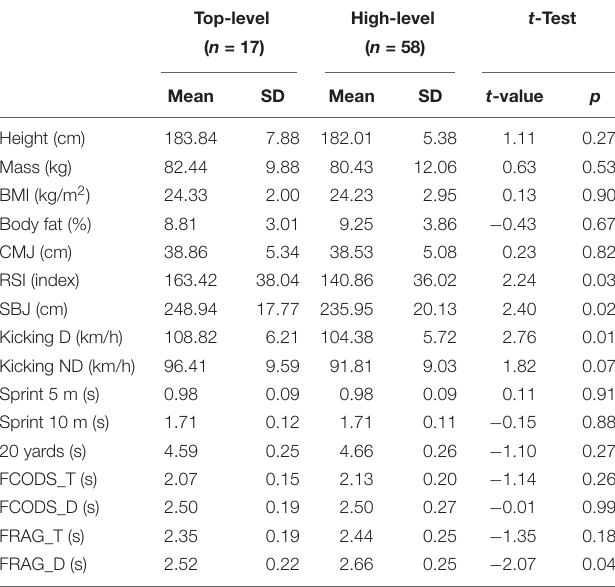
TABLE 4 | Univariate differences between top-level players and high-level players in studied variables ( t -test for independent samples). Top-level High-level t